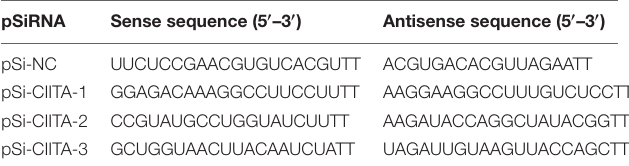
TABLE 3 | The sequences of